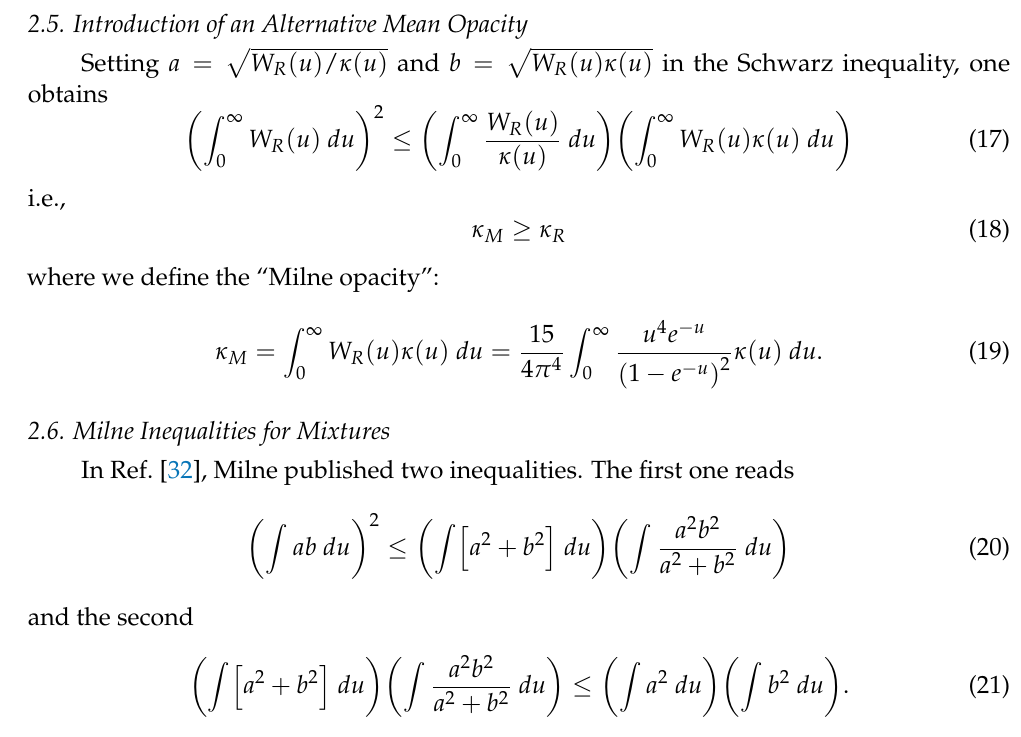
Table 1. Values of integral bound for S in the case of an iron plasma at T = 200 eV and ρ = 0.25 g (cid:0)